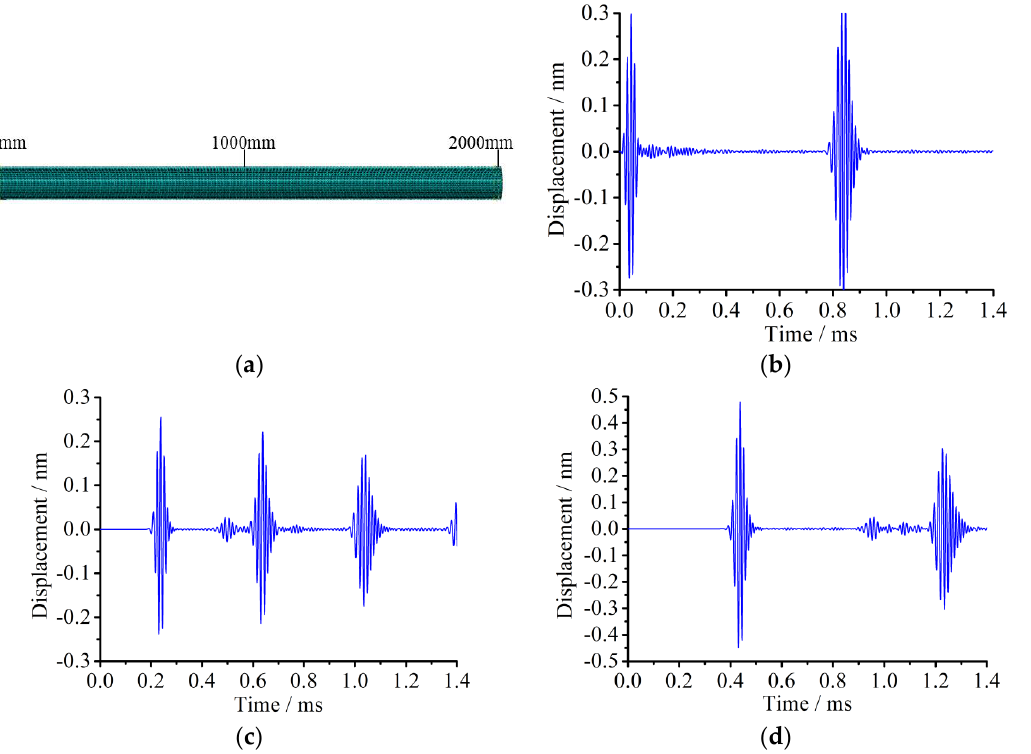
Figure 7. The meshing and displacement time histories at different nodes in the simulation. ( a ) The meshing of the pipe structure; ( b ) The nodal displacement time history at the position of 0 mm; ( c ) The nodal displacement time history at the position of 1000 mm; ( d ) The nodal displacement time history at the position of 2000 mm.